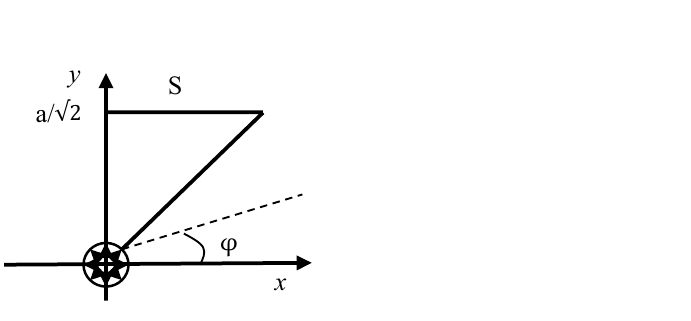
Figure 3. Decomposition of the lower half coordinate system on the complete contact theory.